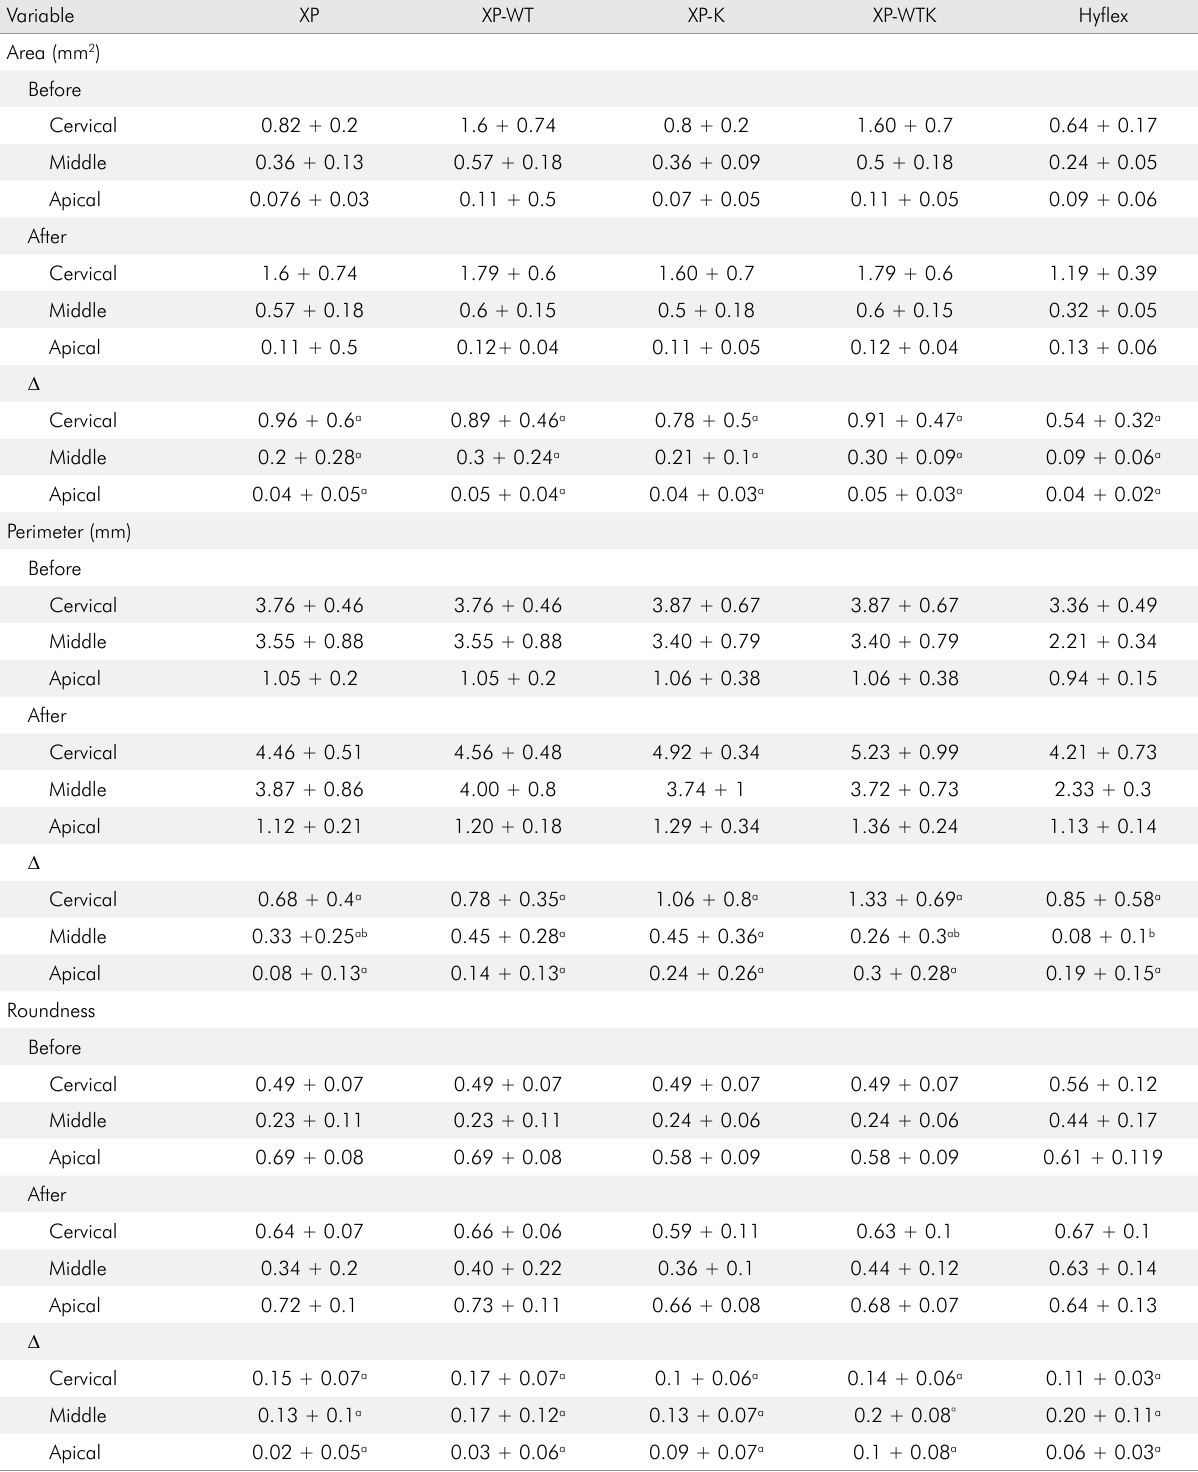
Table 1. Morphometric two-dimensional data (mean + standard deviation) for parameters evaluated at the apical, middle, and cervical thirds of root canals of mesial mandibular molars before and after root canal preparation.